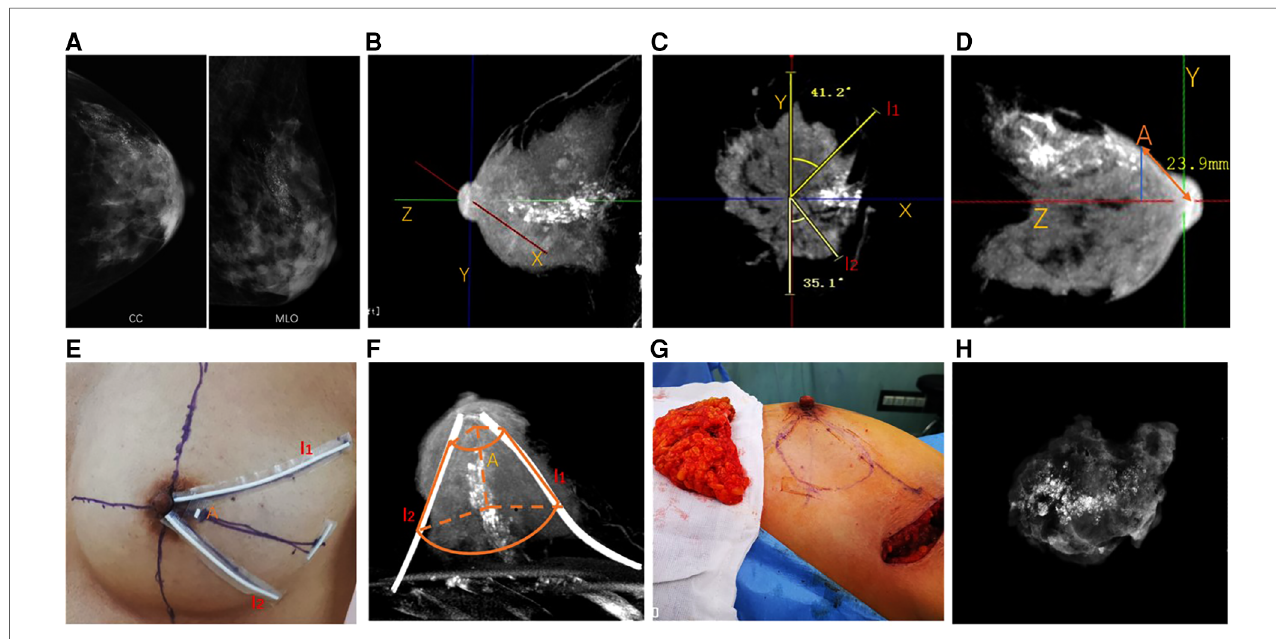
FIGURE 1 Cone-beam breast CT-guided surface location and breast-conserving surgery in breast cancer patients with extensive malignant calci fi cations. ( A ) Mammography showing extensive microcalci fi cations. ( B ) Perpendicular axes ( X , Y , Z ) were established from the nipple corresponding to the medial- lateral dimension, inferior-superior dimension, and axis of the breast, respectively. ( C ) Two radiate margins l 1 and l 2 were marked 5 mm away from the remotest borders of the tumor in coronal images, and the degrees from l 1 and l 2 to the axis were recorded. ( D ) Most frontal borders of the tumor were located in sagittal images and were projected onto the skin to locate landmark A. The distances between the nipple and landmark A were recorded. ( E ) Skin location of landmark A and margins l 1 and l 2 were marked using radiopacity materials. ( F ) CE-CBBCT was reperformed to ensure the margins of skin markers covered the entire lesions. The truncated-cone-shaped area, which was outlined laterally by l 1 and l 2 and coronally through point A and the thoracic wall, would be removed during BCS. ( G ) Oncoplastic breast-conserving surgery was performed according to surface location, and an intraoperative frozen section was used for margin assessment. ( H ) Intraoperative specimen x-ray imaging was applied to double-check that the entire lesion was removed. CE-CBBCT, contrast-enhanced cone-beam breast computed tomography; BCS, breast-conserving